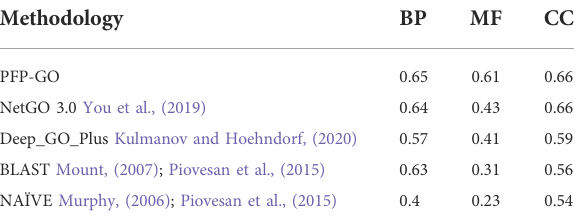
TABLE 6 Performance analysis of PFP-GO with other methods based on Fmax score.